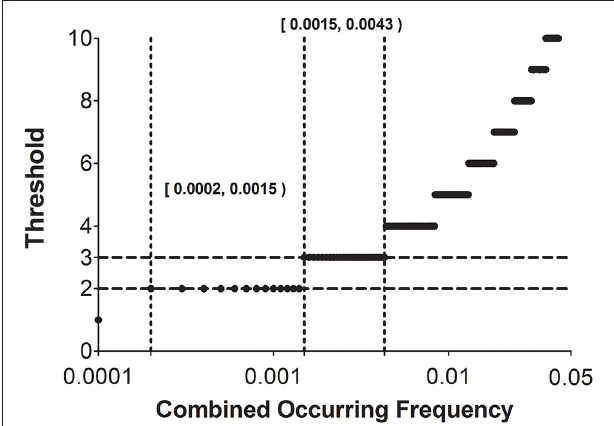
FIGURE 5 | Thresholds of recurrent sound correspondences under different combined occurring frequencies of involved sound segments (0.0001–0.05, with a step 0.0001). Two regions marked by dotted lines [0.0002, 0.0015) and [0.0015, 0.0043), respectively, denote the ranges of combined occurring frequencies where the threshold can be set to two and three.